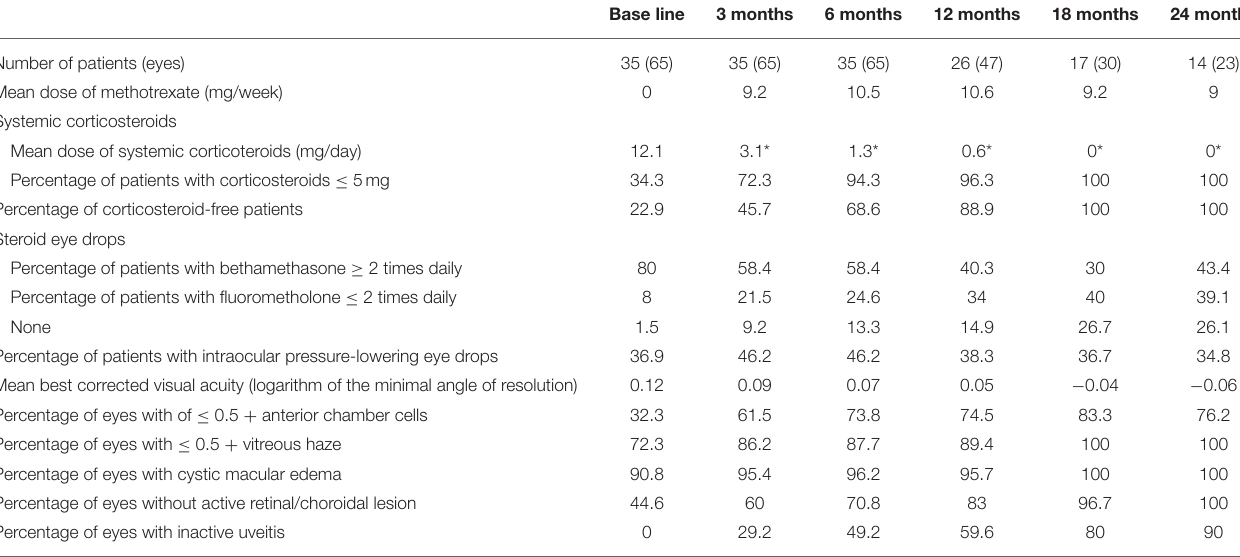
TABLE 2 | Treatment outcomes of patients with non-infectious uveitis treated with methotrexate.